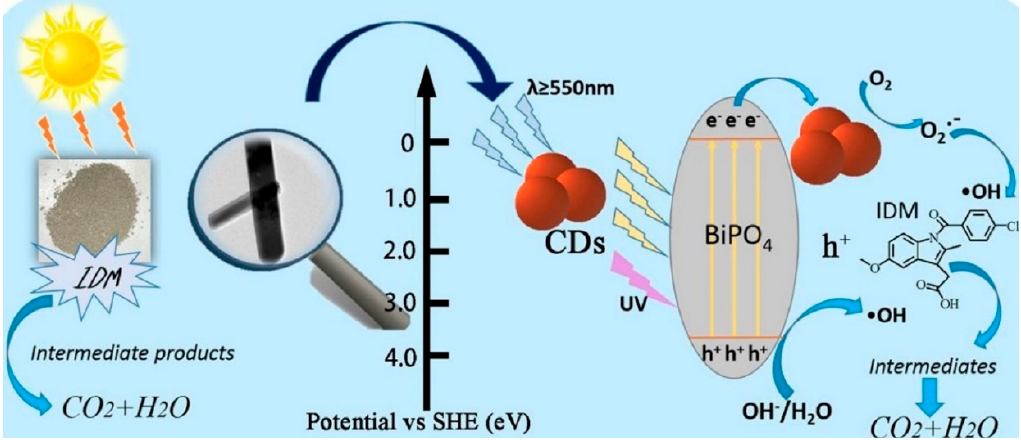
Figure 6. The schematic photocatalytic mechanism of indometacin (IDM) degradation by the CDs-doped BiPO 4 composite under irradiation of simulated sunlight. Figure adapted from reference [105].